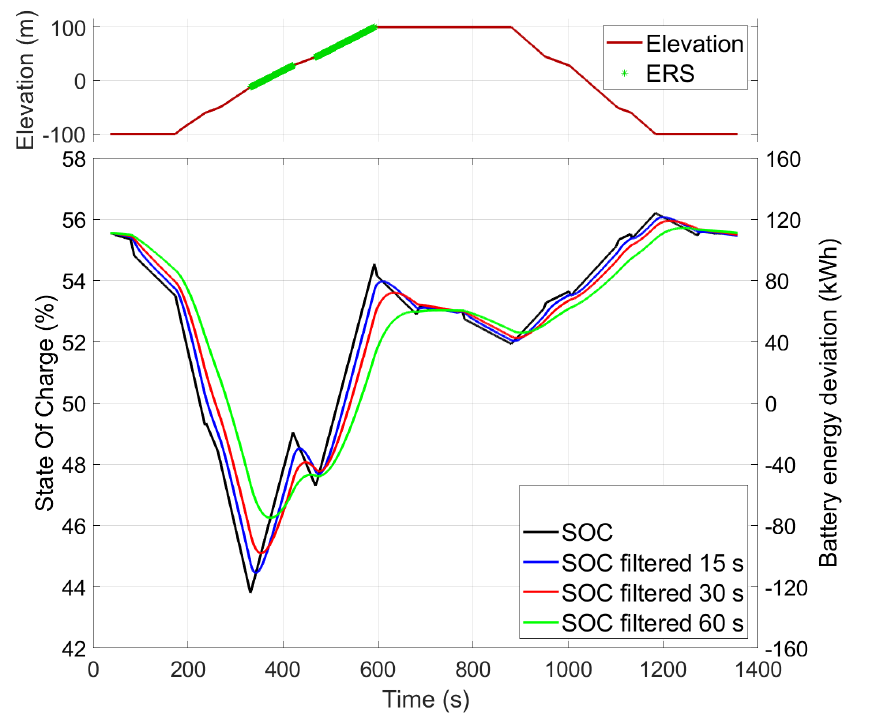
Figure 10. Battery state of charge for the Short 2 drive cycle with the “Battery + ERS” drivetrain. Three low-pass filtered versions of the state of charge are also shown. Elevation and ERS placement shown for